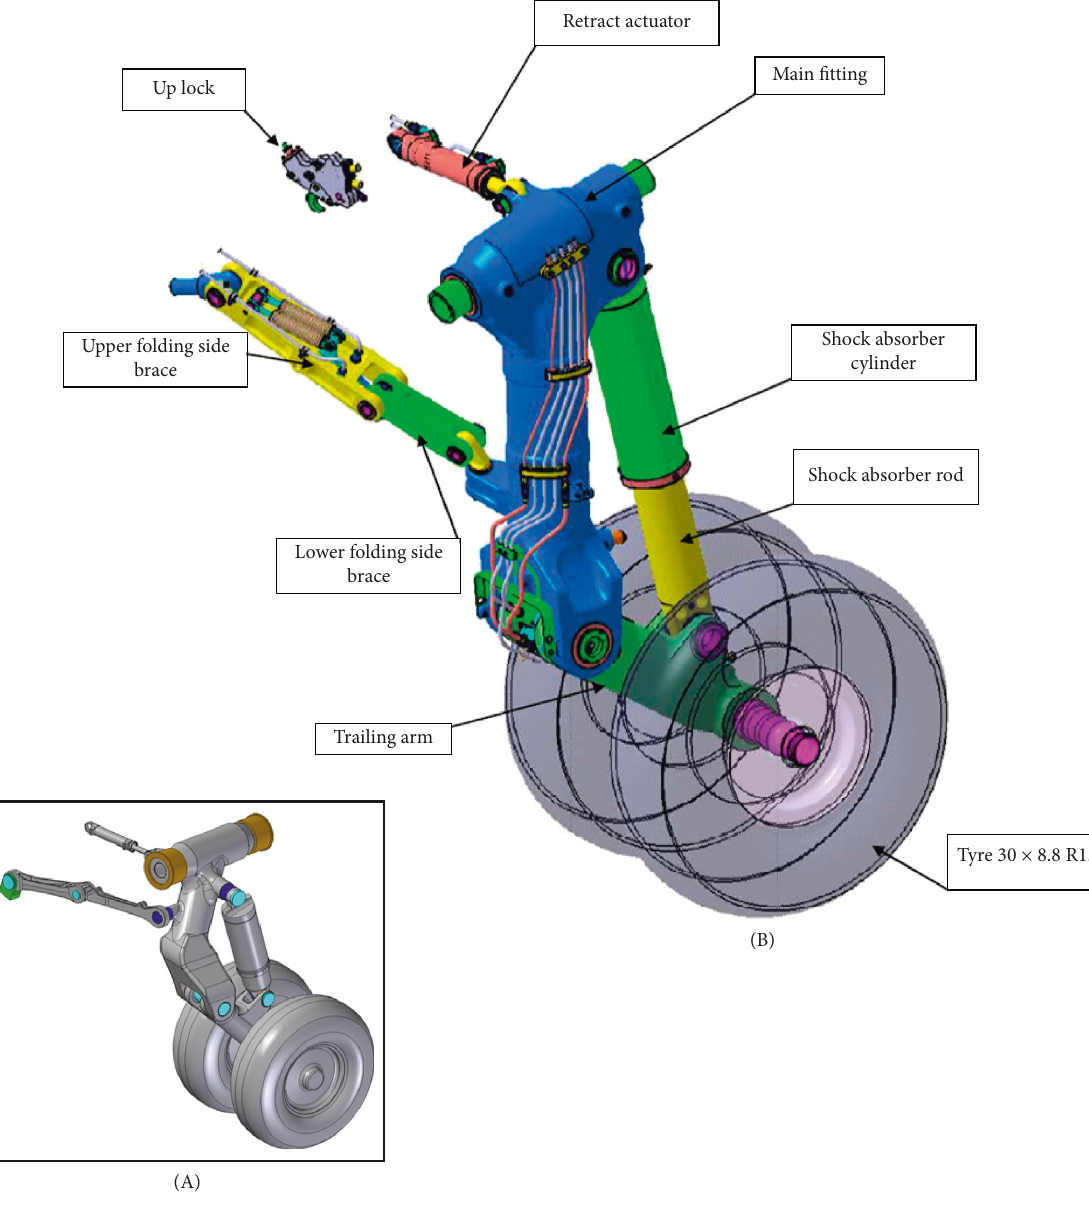
Figure 5: Landing gear: (A) multibody model; (B) main structural components.